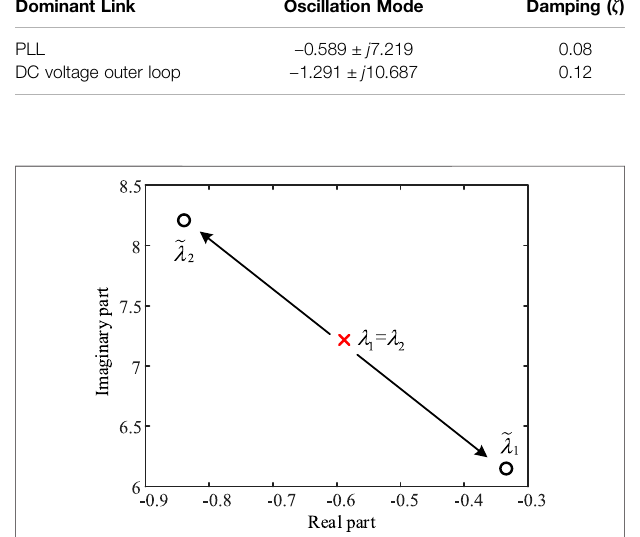
FIGURE 7 | OLMR phenomenon of λ 1 and λ 2 .